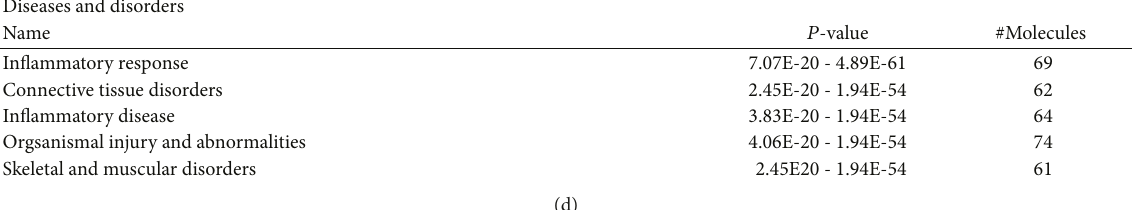
Figure 2: Altered production of cytokines and chemokines caused by gain or loss of DICER1 function for 48 h in human synoviocytes SW982. (a) Image result of cytokine array detecting conditioned medium from cells transfected with DICER1 or NC siRNA for 48 h. Two membranes were incubated with SW982 cell supernatant transfected by either negative control or DICER1 siRNA for 48 h. (b) Fold change of cytokine expressioninconditionedmediumofthecelltreatedby DICER1 siRNAfor48hwasdetectedbyusingcytokinearray(quantitativeresultof(a)). Cytokineswithfoldchangebeyond ± 1.5wereshown.(c)ELISAassayresultforIL-8,TGF- β 1,andTIMP1cytokineexpressioninsupernatantof SW982 cells with DICER1 KD or overexpression. Bar: mean ± SEM from three independent transfection experiments. Triplicates were used for each transfection experiment, and duplicates were used in ELISA assay. ∗ P < 0 05 using the Mann-Whitney test. (d) IPA predicted top 5 diseases and biofunctions related to Dicer1 de fi ciency-induced altered production of cytokines and